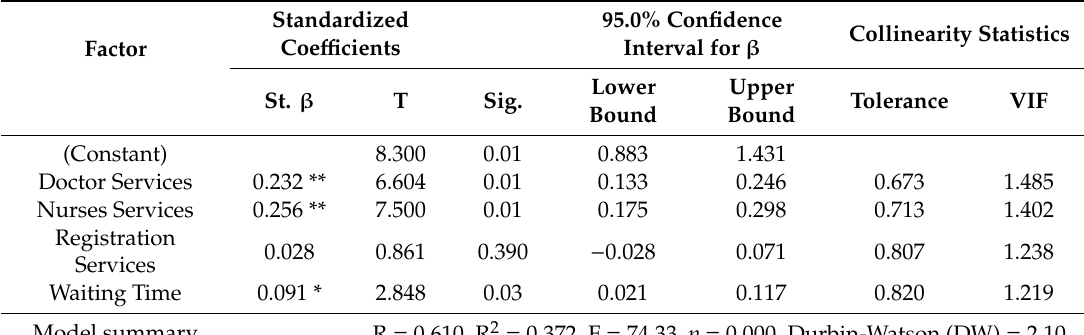
Table 4. Multiple regression models (dependent variable: Patient